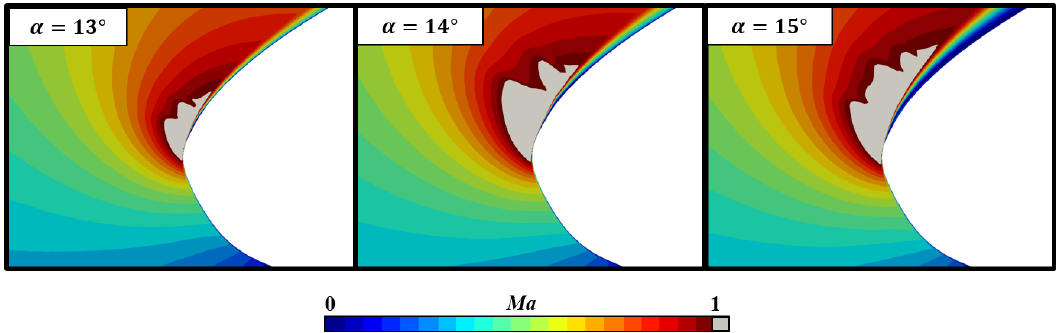
Figure 14. A supersonic pocket near the leading edge in the